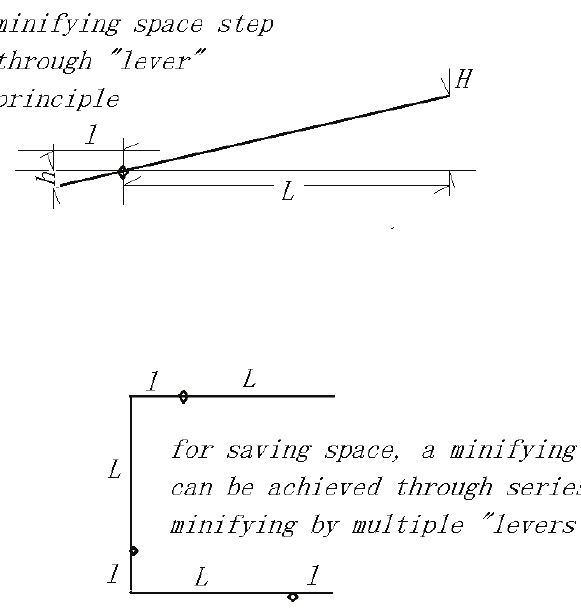
Figure 1. Sketch of field configuration ( a ) and experimental setup ( b ).